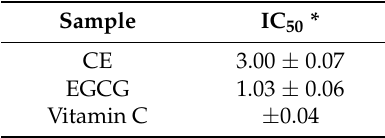
Table 1. Antiradical activity of tested samples according to DPPH assay.